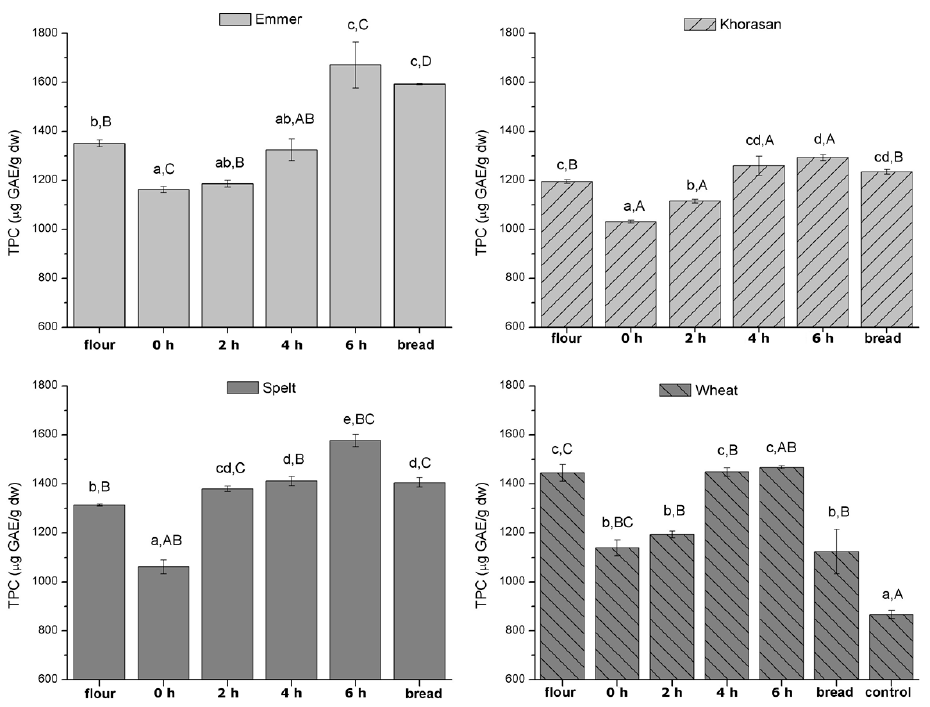
Figure 2. Evolution of total phenolic content during 6 h of sourdough preparation and breadmaking. Different lowercase letters indicate statistically significant differences within the group of the same wheat variety, while different uppercase letters indicate statistically significant differences between different wheat varieties in all stages individually (flour, different intervals of dough fermentation time and sourdough bread). Control refers to yeast fermented wheat flour bread, used as reference bread for comparison with the obtained sourdough